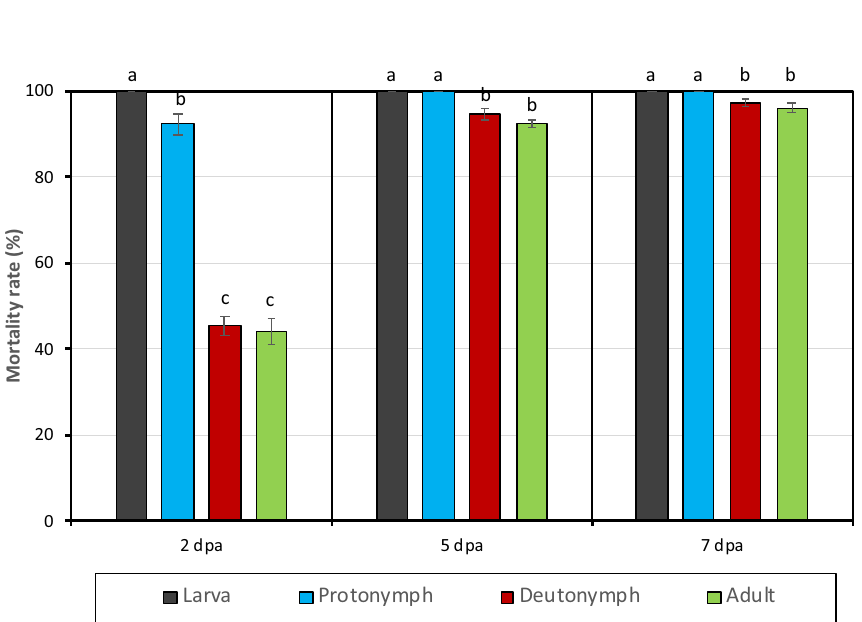
Figure 6. The effects of the extracted acaricidal compound (xenocoumacin) on different biological stages of Tetranychus urticae in Petri